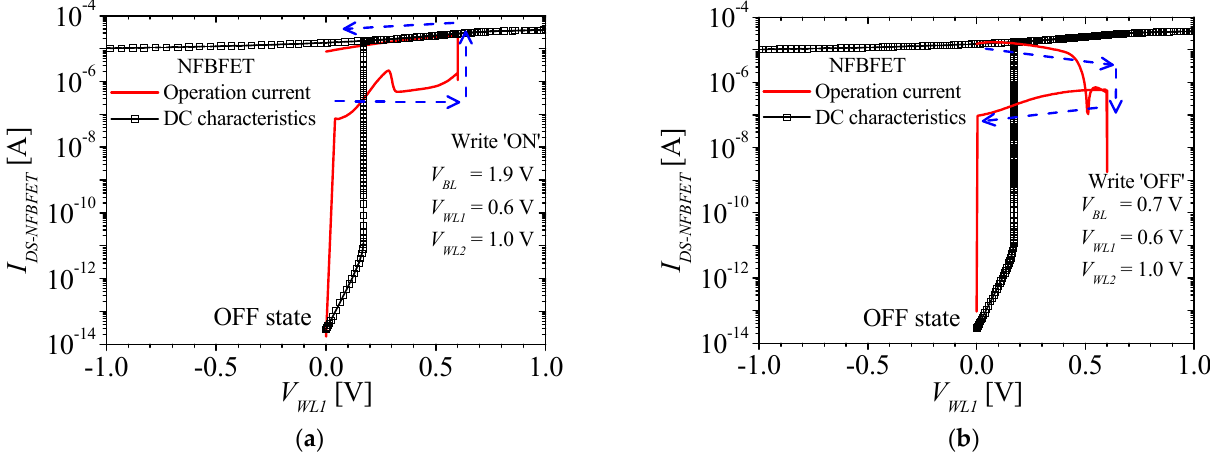
Figure 4. The NFBFET current during the ( a ) writing ‘ON’ operation and ( b ) writing ‘OFF’ opera- tion.